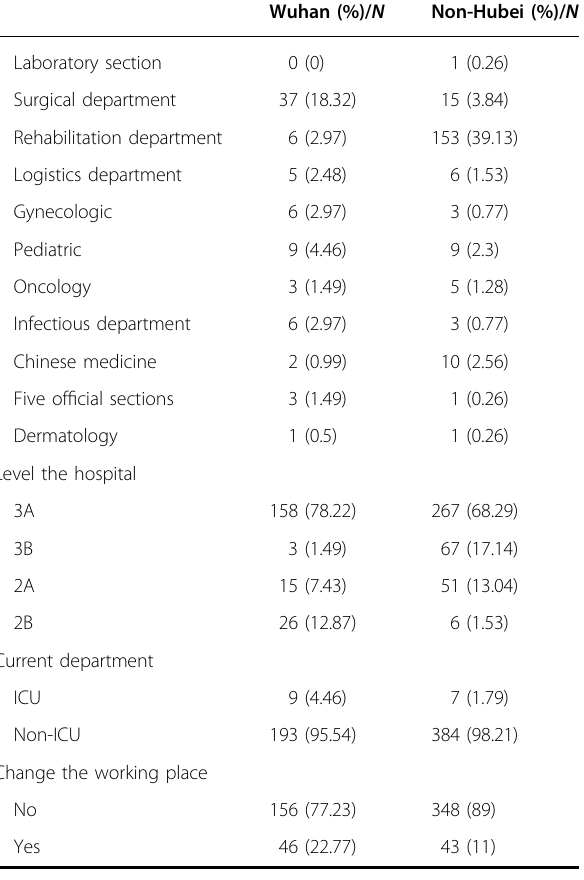
Table 1 Demographics and baseline characteristics of nurses on